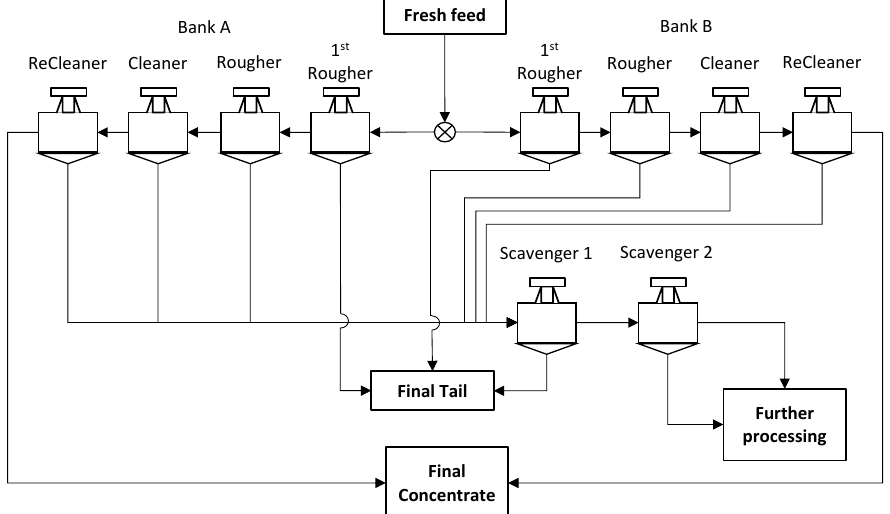
Figure 1. Diagram highlighting the process flow of line 1 coarse flotation at Brucutu.